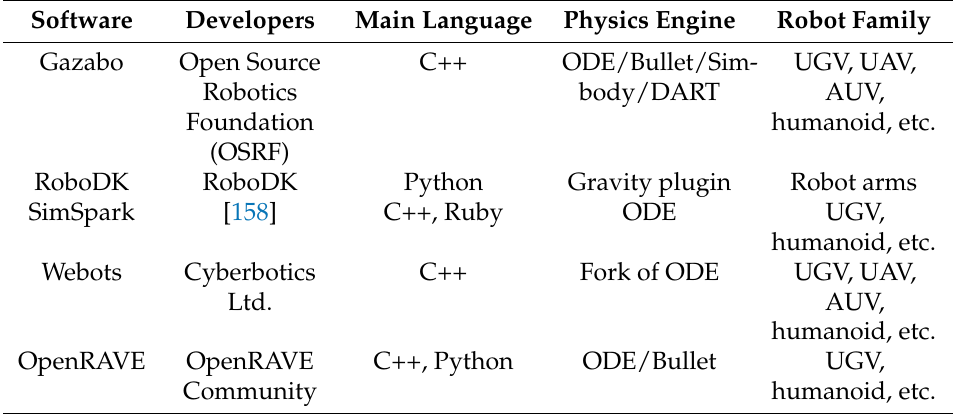
Table 4. Robotics simulators, adapted from Wikipedia (2021)